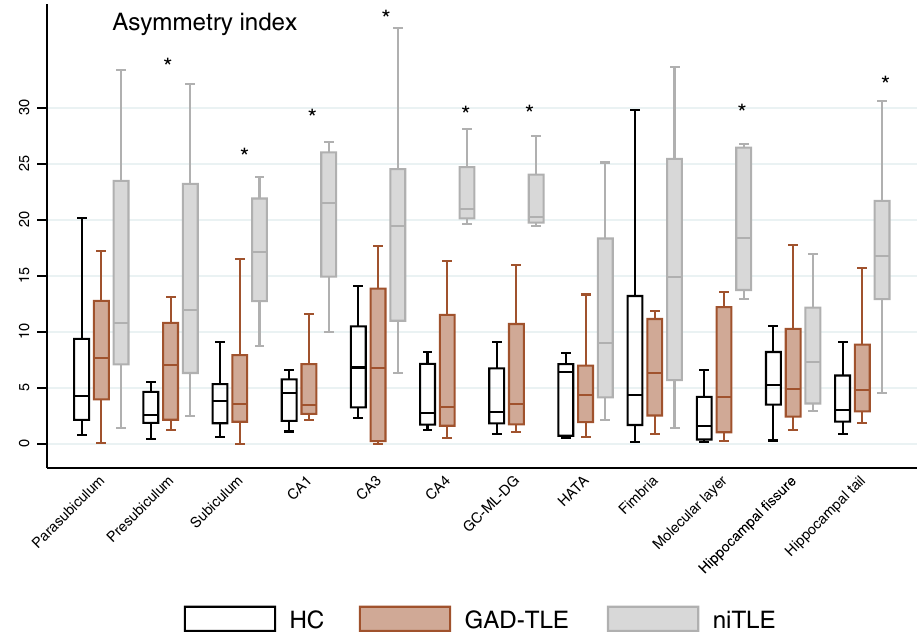
Figure 2. Asymmetry index: significant asymmetry towards the contralateral hippocampus in GAD-TLE compared to niTLE and HC. *Significant asymmetry in each subfield (Kruskal–Wallis